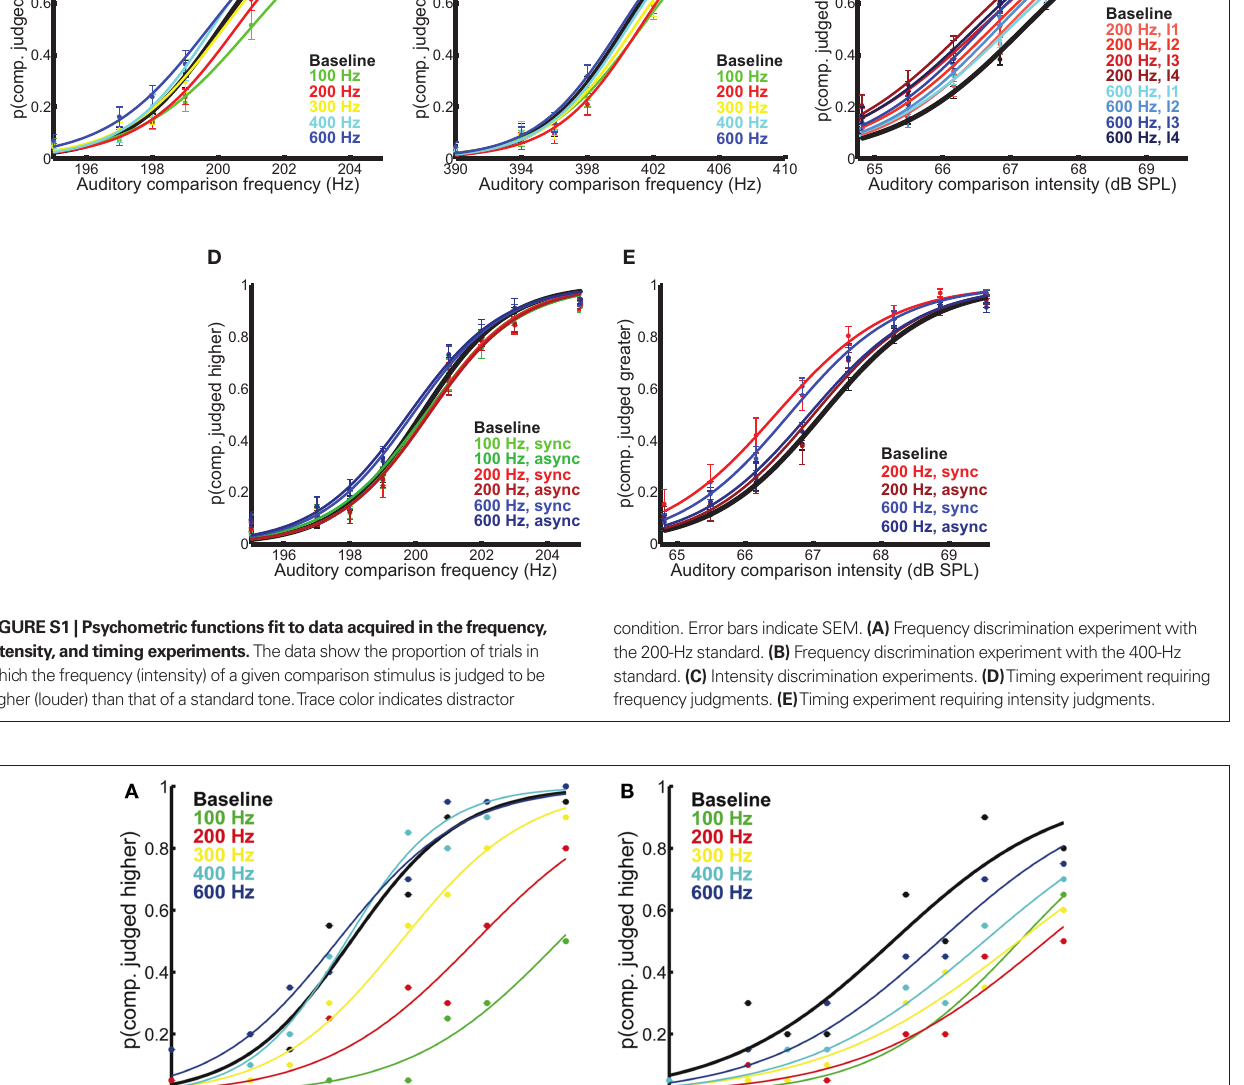
Figure S2 | Psychometric functions fit to individual subjects in the frequency discrimination experiments. The data show the proportion of trials in which the frequency of a given comparison stimulus is judged to be higher than that of the standard tone. Trace color indicates distractor condition. Distractors at frequencies lower than that of the test stimuli induced larger bias effects in experiments using the (A) 200-Hz standard and (B) the 400-Hz